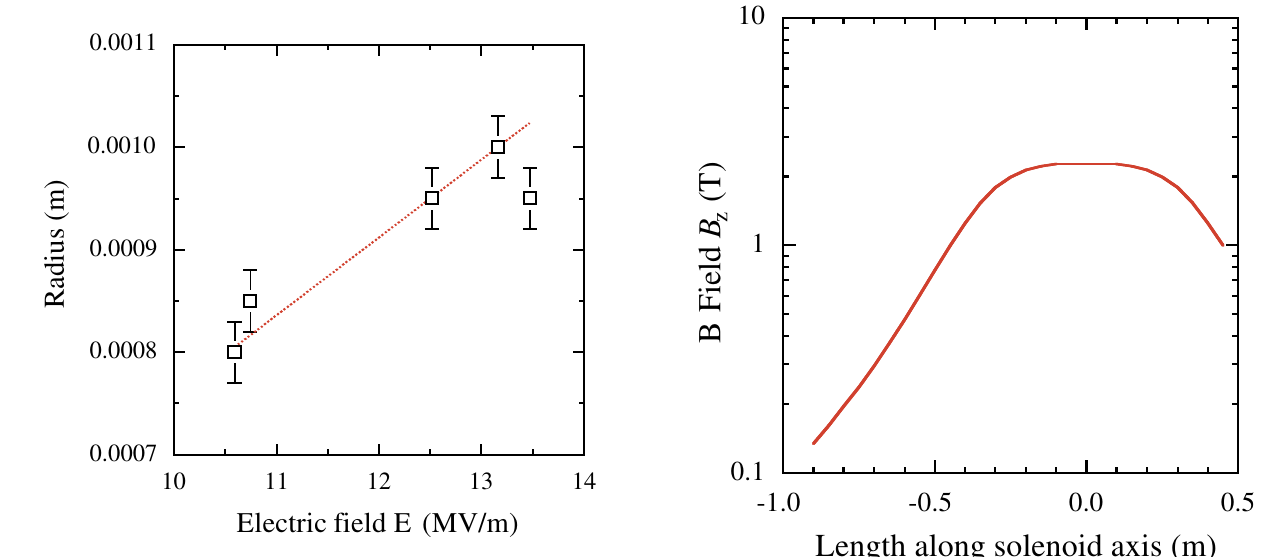
FIG. 19. (Color) Radii of beamlets in the inner band as a function of the accelerating